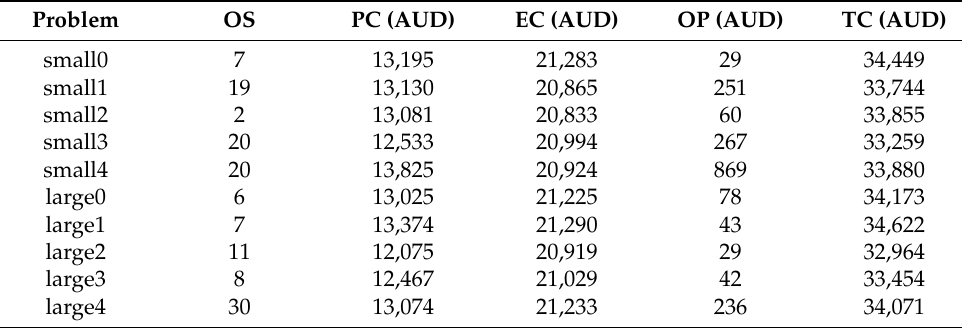
Table 7. Detailed results of our approach on all ten problem